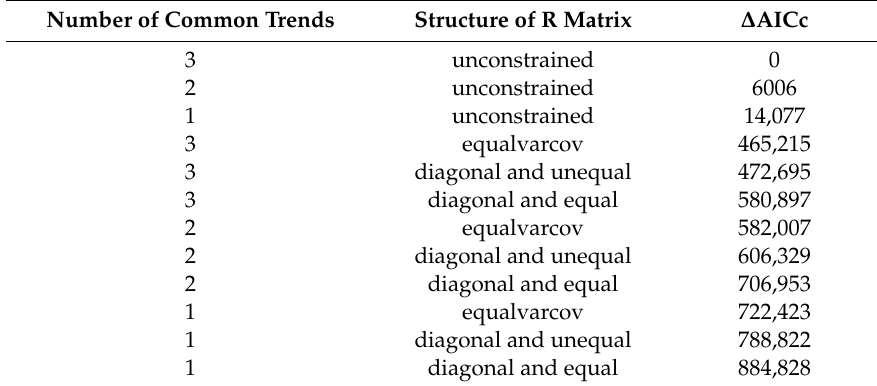
Table 1. The Akaike information criterion (AICc) values of the dynamic factor models relative to each other based on the structure of variance-covariance matrix (R matrix) and the number of common trends determined. Number of Common Trends Structure of R Matrix ∆ AICc 3 unconstrained 0 unconstrained 6006